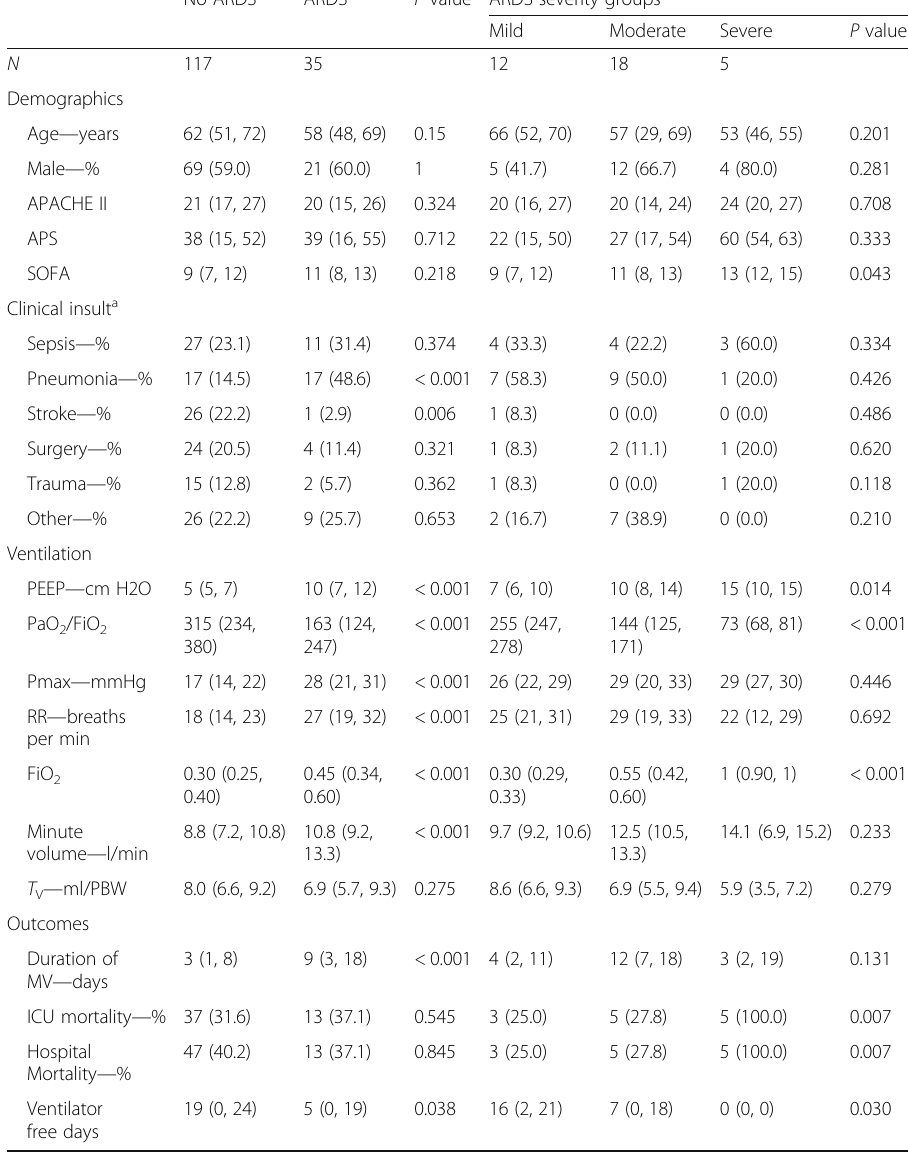
Table 1 Patients baseline, ventilation, and outcome